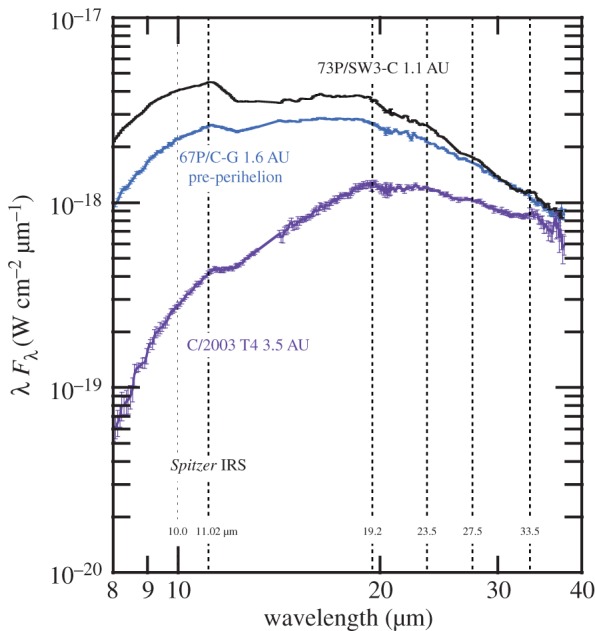
Three comets with low-contrast silicate features and with weak forsterite (Fo100) resonant peaks. Their grain size distributions have grains as small as around 1 μm radius. Shown are the Spitzer IRS spectra of 73P/Schwachmann-Wachmann 3°C[304], as well as (MSP Kelley 2016, personal communication) 67P [305] and C/2003 T4 [306]. (Online version in colour.)